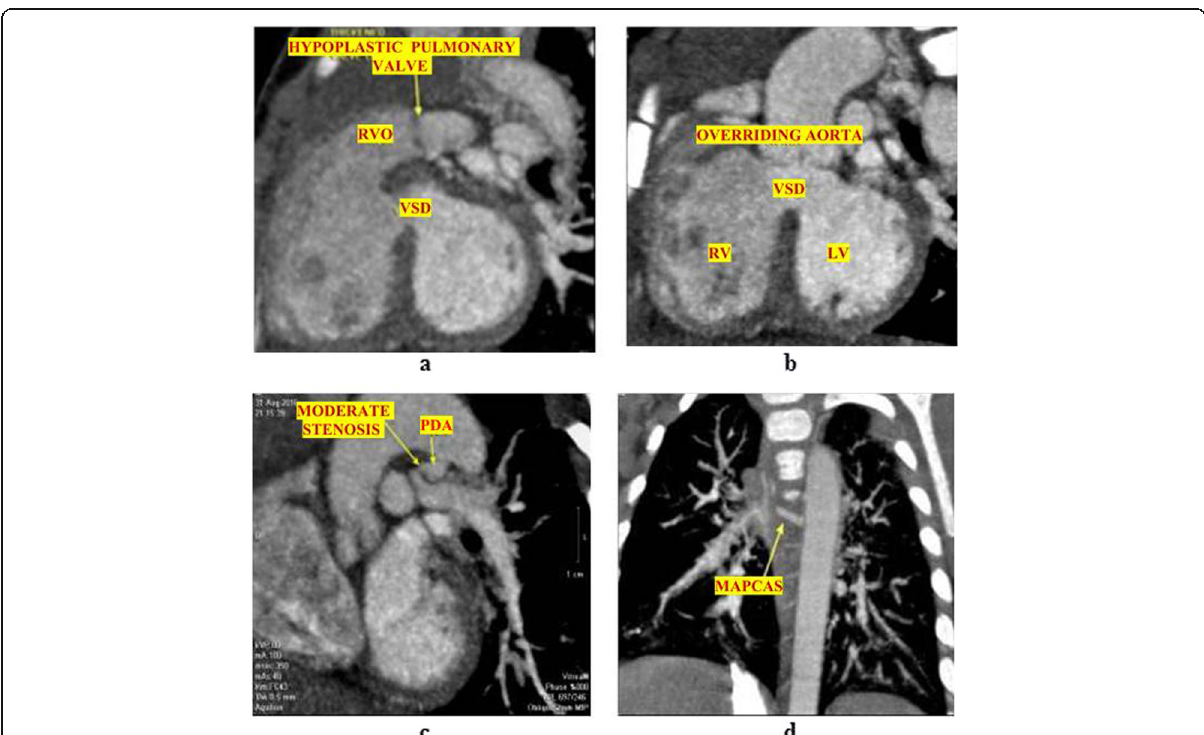
Fig. 1 Seven-month-old male patient presents with cyanosis. ECHO revealed right atrioventricular dilatation, pulmonary stenosis, VSD, and overriding aorta (tetralogy of Fallot). ECG-gated multi-slice CT angiography of the heart and great vessels confirmed the presence of the pulmonary valve stenosis and ventricular septal defect with overriding aorta on a and b MIP images. It also detected the presence of patent ductus arteriosus on reformatted CT angiography oblique coronal image ( c ) and major anomalous aortopulmonary collateral arteries on coronal MIP image ( d ) that were not detected by